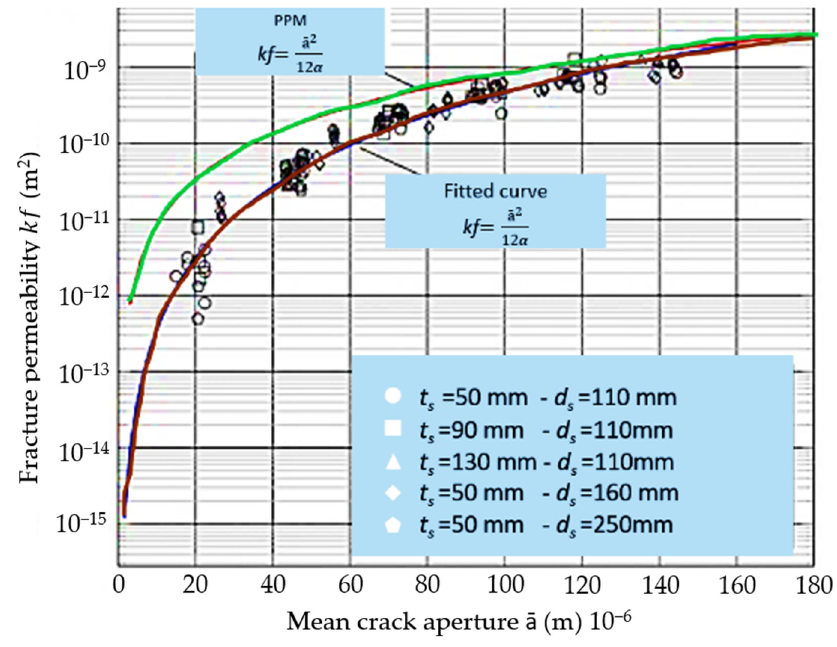
Figure 20. Estimation of fracture permeability for concrete cylindrical specimens of di ff erent diam- eters (d s ) and thicknesses (t s ) green lined curve represents the Parallel Plate Model (PPM) and the red lined curved is the fi tt ed curve (Adapted with permission from reference [80]).